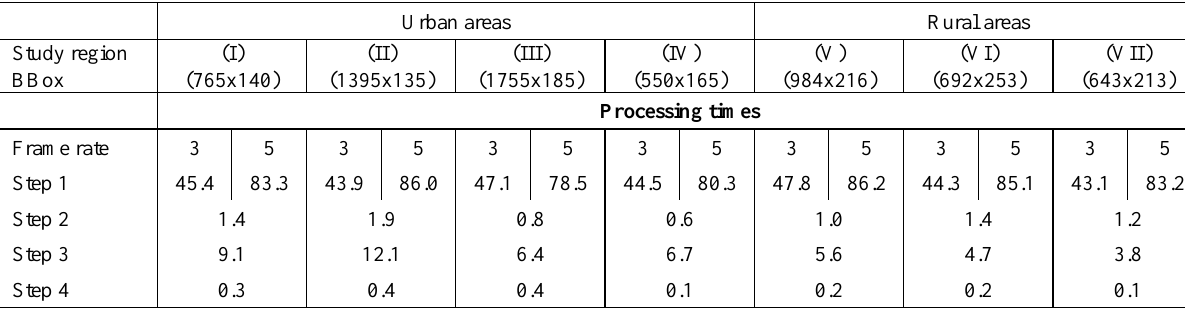
Table 2. Summary of processing times regarding two frame rates of 3 & 5 fps with a time lapse interval of 5 seconds to observe the study areas (I)-(VII). Bounding box (BBox) for ROI description in pixels. Processing times in seconds with respect to single processing steps: (1) Co-registration, average image & spatio-temporal texture calculation, (2) Histogram analysis & initialization of step (3) image segmentation, (4) water line extraction.